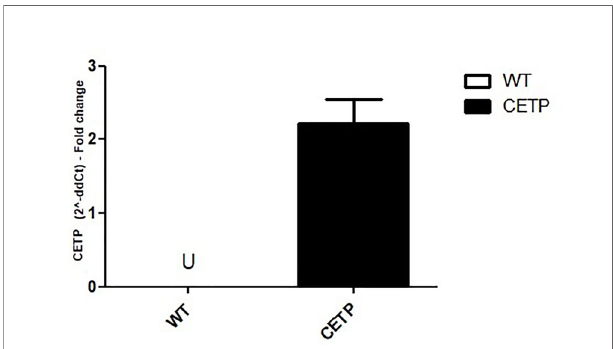
FIGURE 1 | Comparison of CETP mRNA expression in bone marrow-derived macrophages from WT and huCETP Tg mice. mRNA expression was determined using RT-PCR. Results are expressed as the mean ± standard deviation. U,